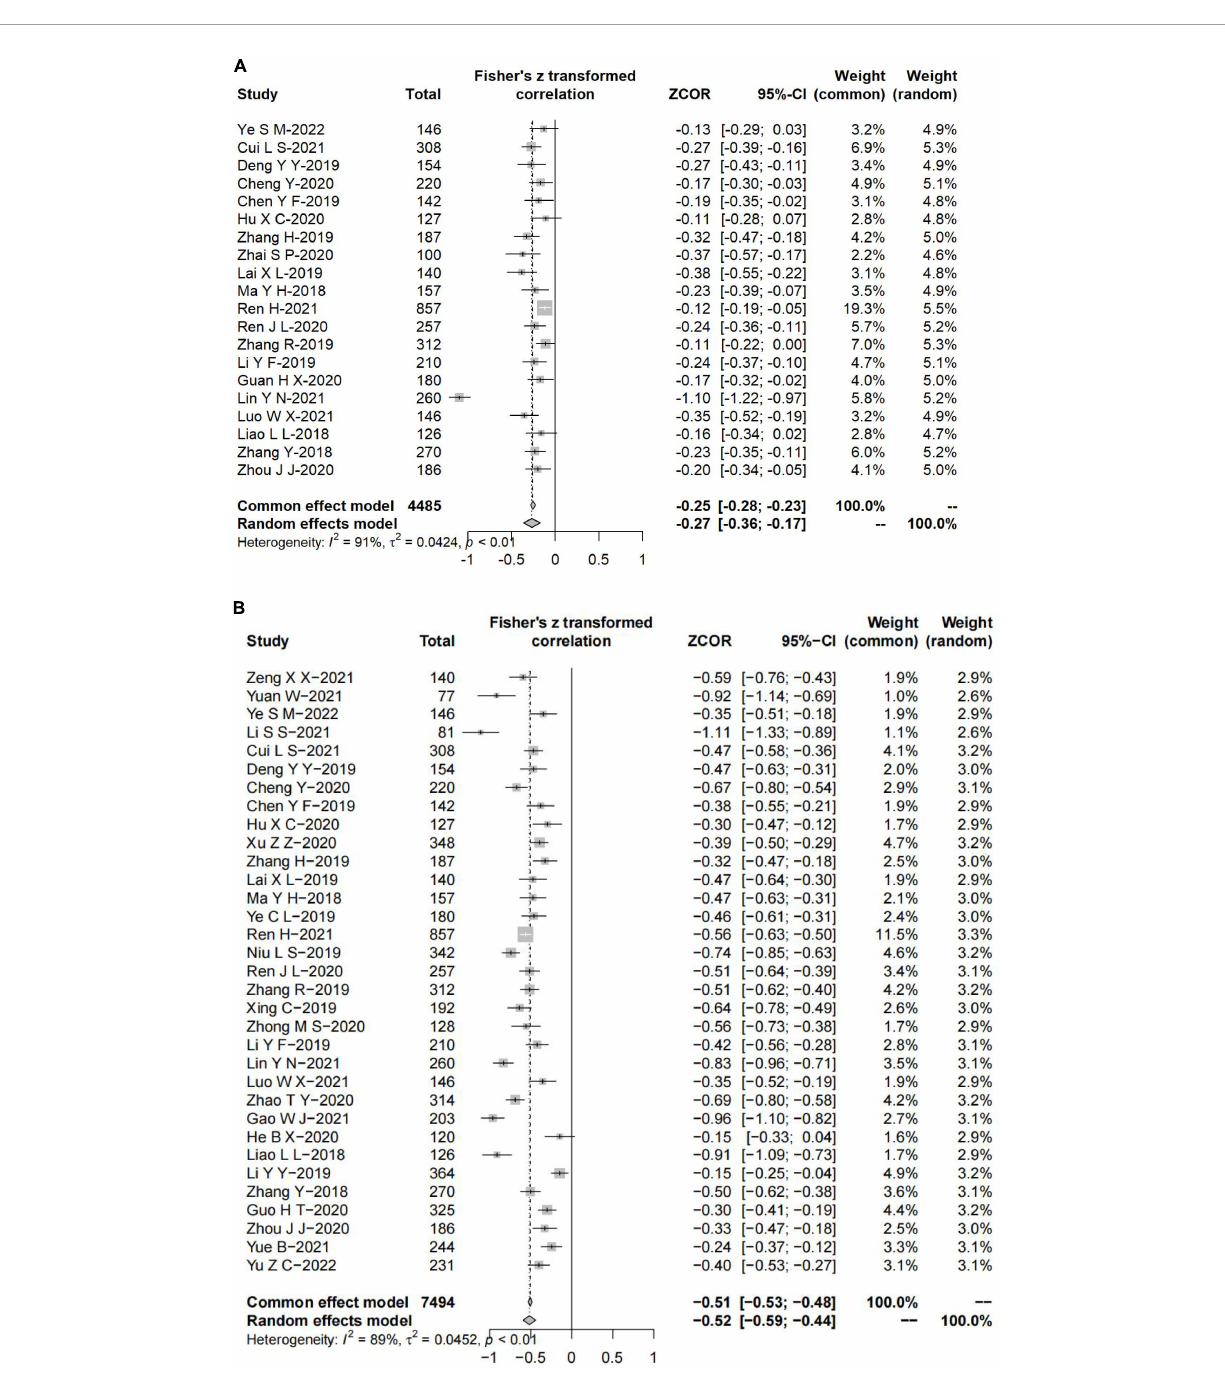
FIGURE2 Forest plots of the pooled β ’ (A) and summary r coefficients (B) ,